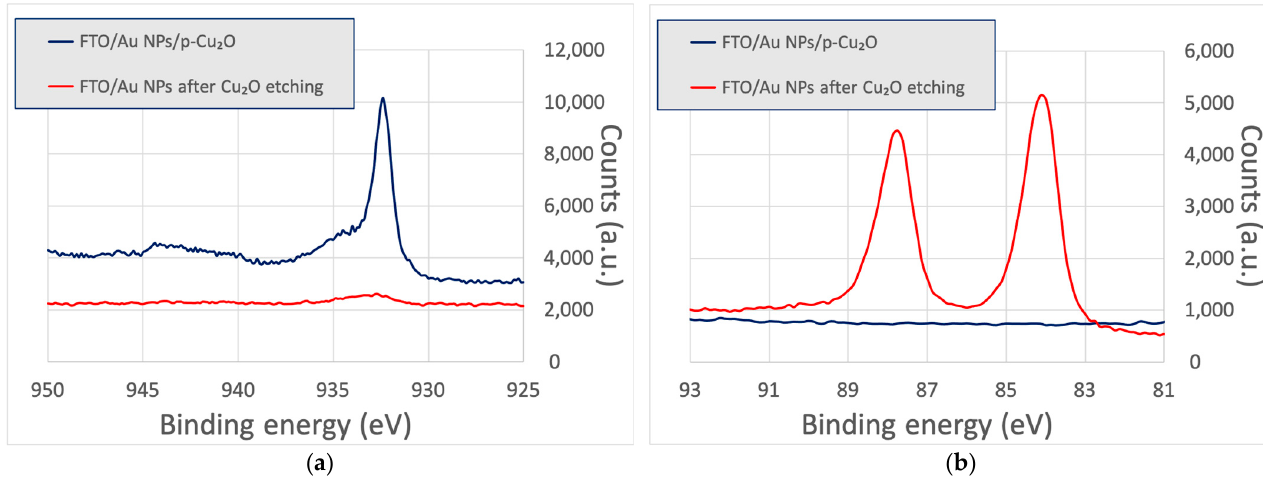
Figure 7. XPS detail scan analysis of the FTO/Au NPs/p-Cu 2 O and FTO/Au NPs after etching pCu 2 O films: ( a ) Cu 2p 3/2 region; ( b ) Au 4f region